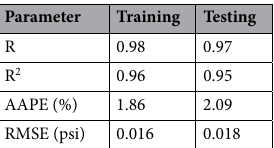
Table 7. Training and testing results for ANFIS model.